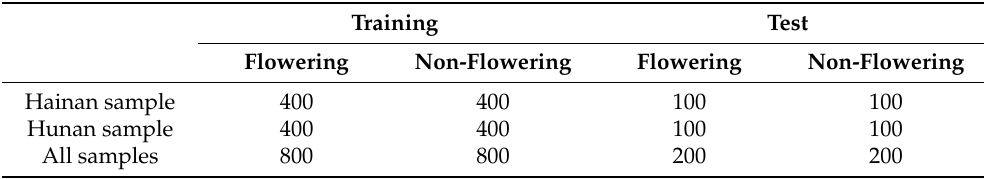
Table 1. Sample size of training and test set of hyperspectral data.